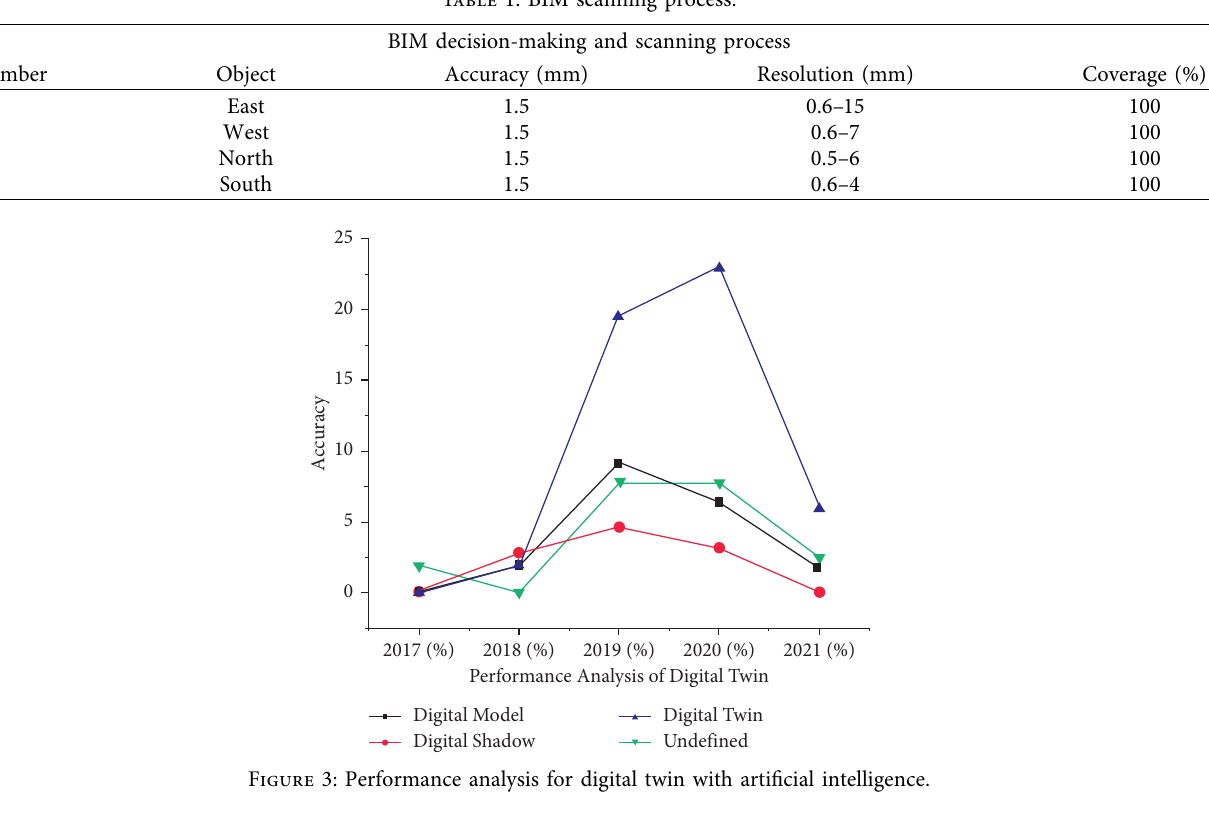
Figure 2: BIM scanning process. Table 1: BIM scanning process.